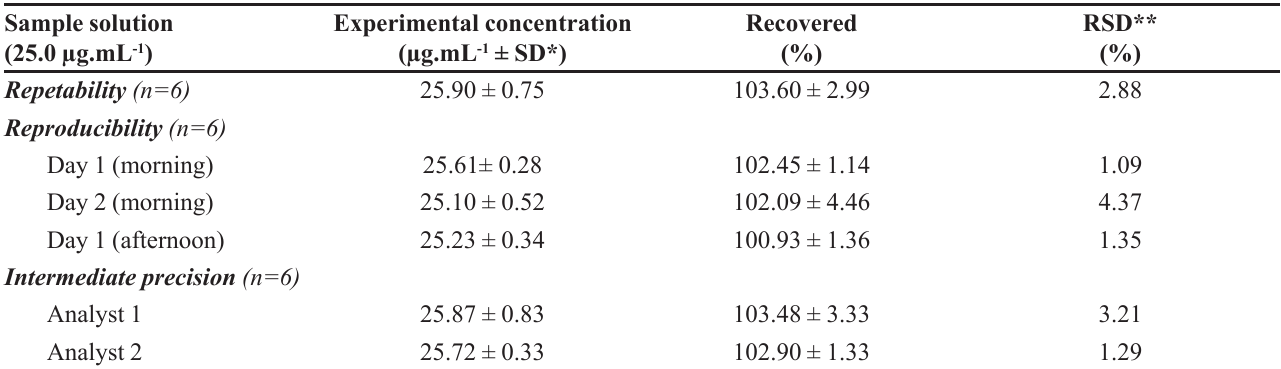
TABLE III - Accuracy assays for halcinonide analysis